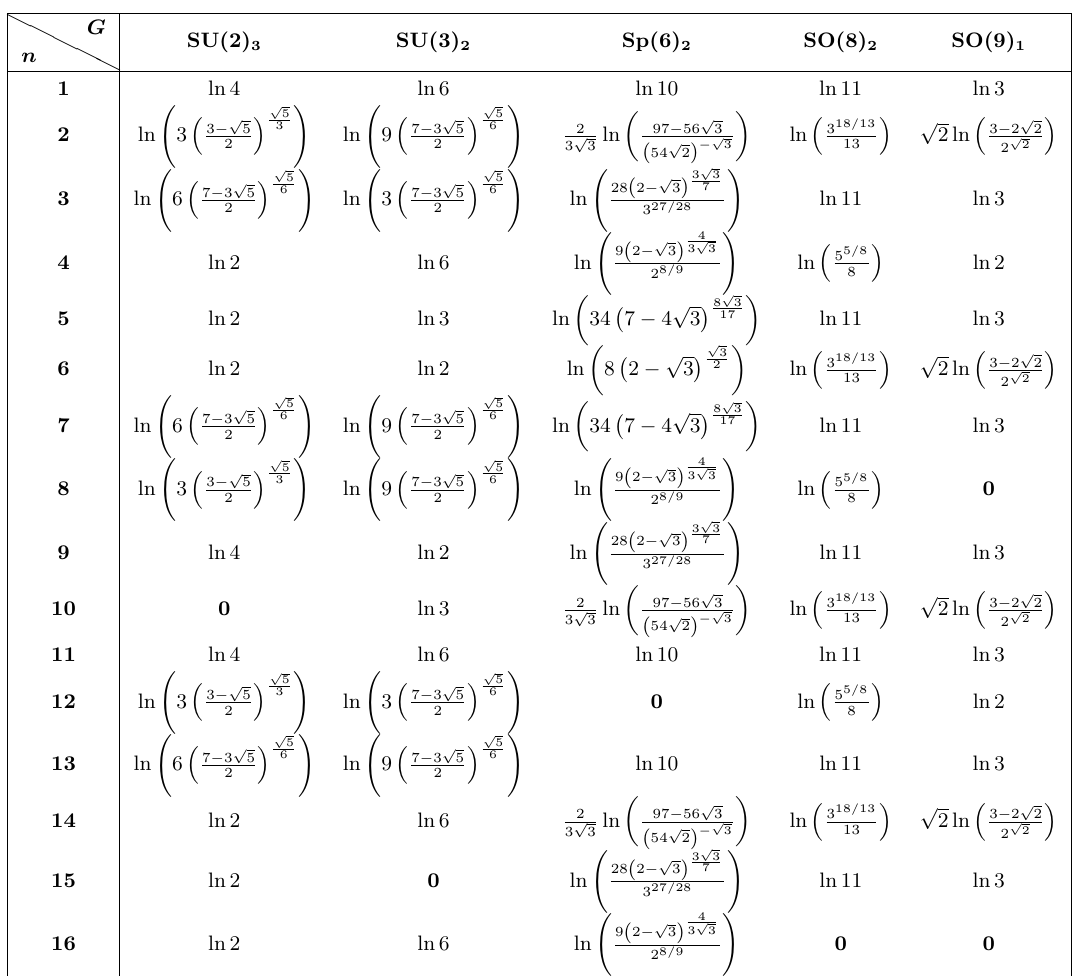
Table 1 . Table listing the entanglement entropy R 1 for T (2 ; 2 n ) link state, for some of the groups G and level k . The values are given for 1 (cid:20) n (cid:20) 16. We can see that within a group and level, we have a periodic behavior with fundamental period p given in eq. (4.14). We can also see